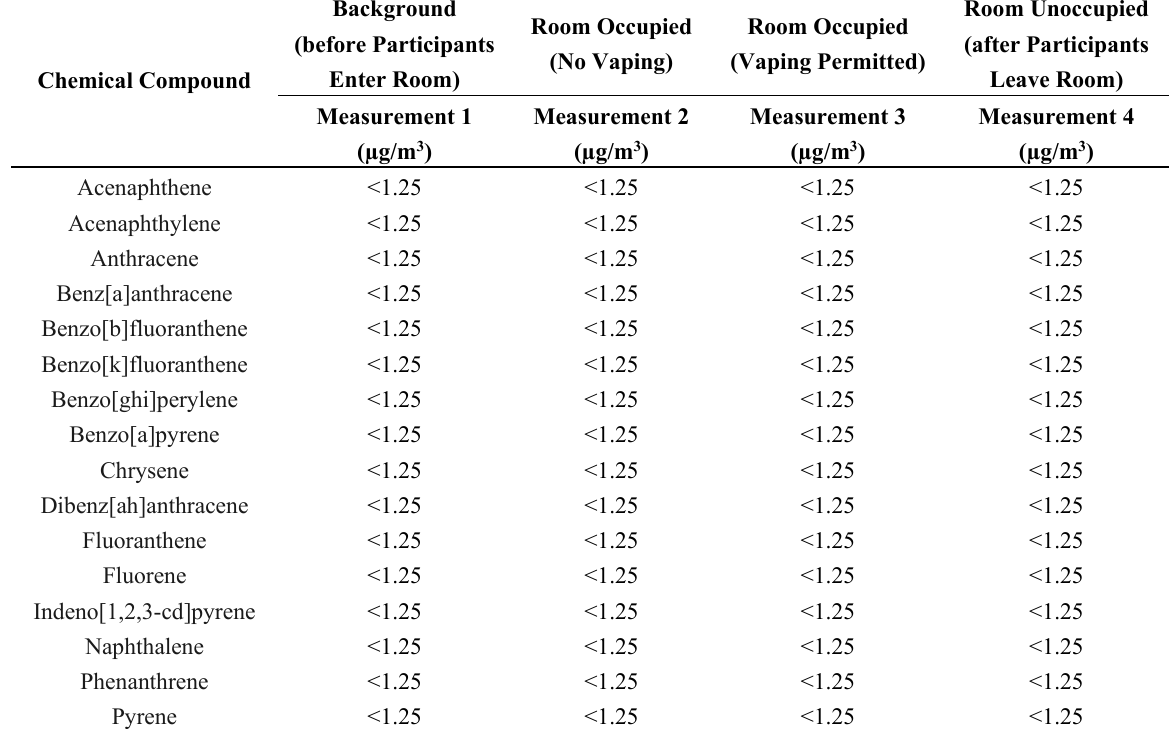
Table 2. Average indoor air concentrations of US EPA “priority list” of 16 PAHs (µg/m 3 ) measured before, during and after use of e-cigarettes from two independent sampling